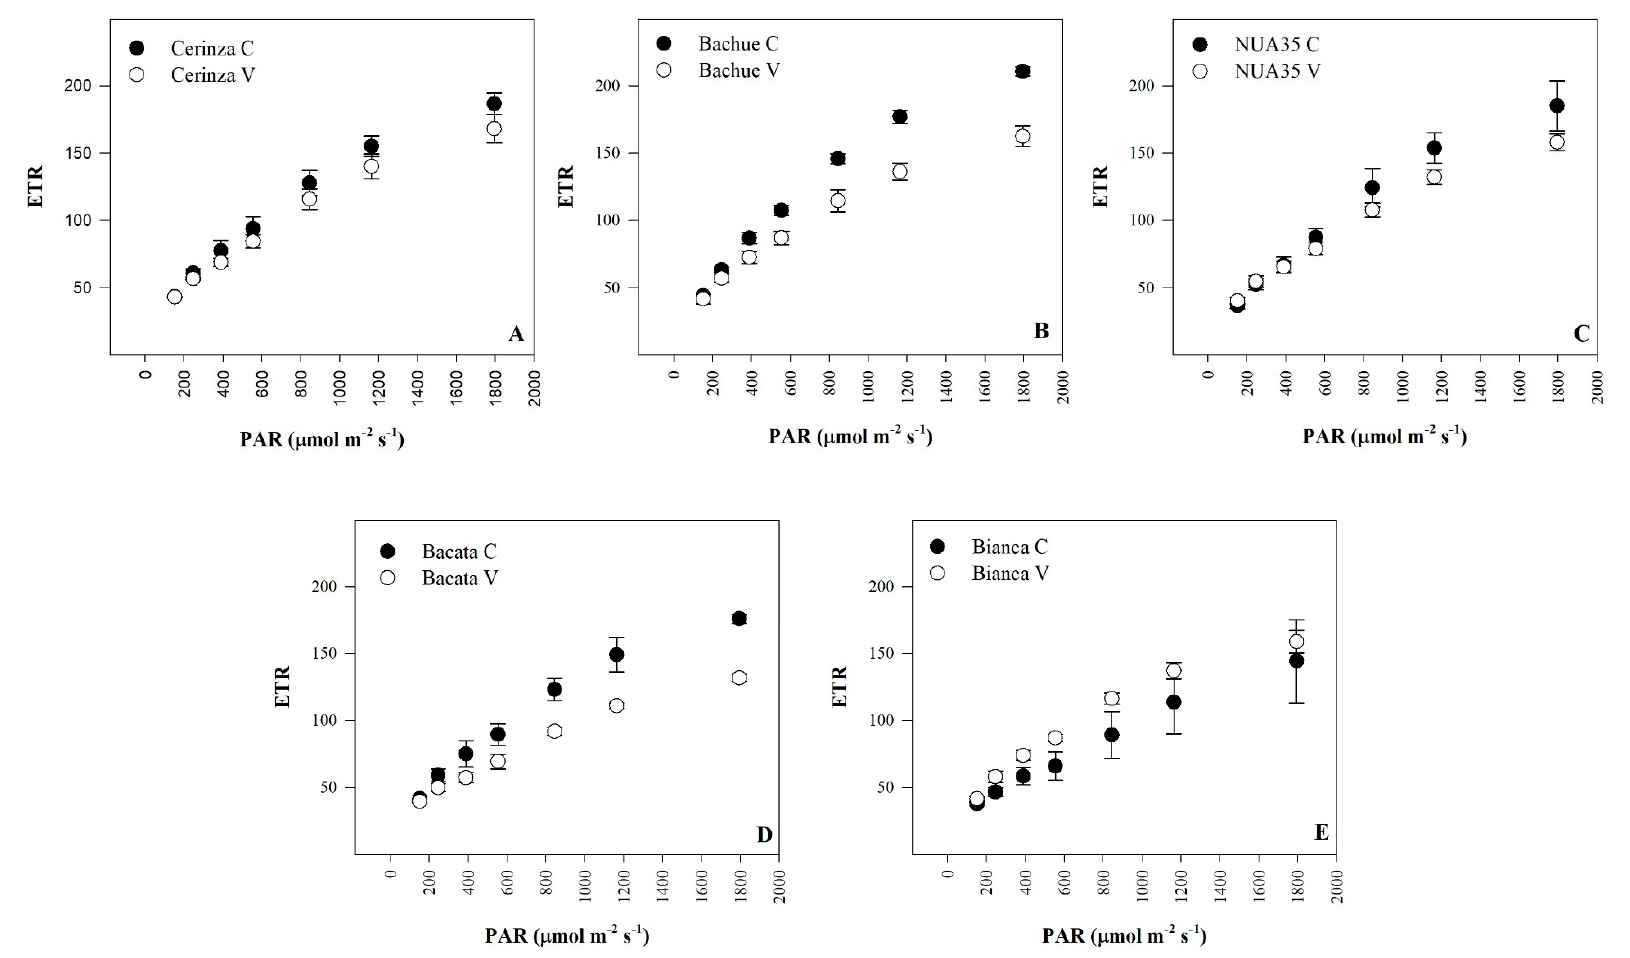
Figure 2. Electron transport rate (ETR) obtained from rapid light-response curves of ‘Cerinza’ ( A ), ‘Bachue’ ( B ), ‘NUA35’ ( C ), ‘Bacata’ ( D ) and ‘Bianca’ ( E ) under two water treatments (control ( (cid:8) ) and water-stressed ( ) plants) at the end of vegetative stage (55 DAE). Data represent the mean of four data points ± standard error; PAR, Photosynthetic Active Radiation.